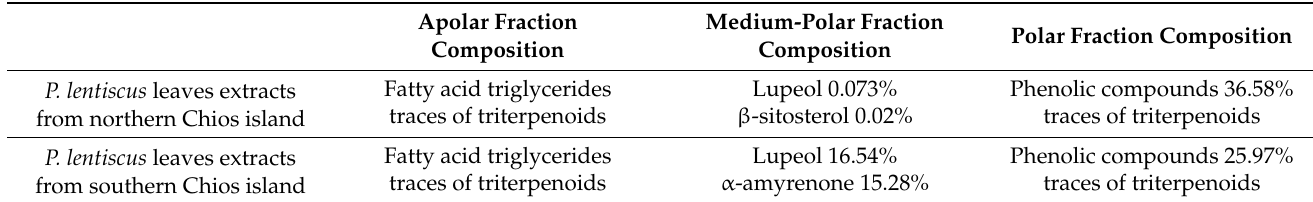
Table 1. Chemical characterization of fractions from northern and southern P. lentiscus leaves extract. Apolar fractions have been analyzed by 1 H-NMR, medium-polar fractions have been characterized by chromatography purification and polar fractions have been divided into MeOH and THF fractions through RP C-18 and subsequently analyzed by 1 H NMR.